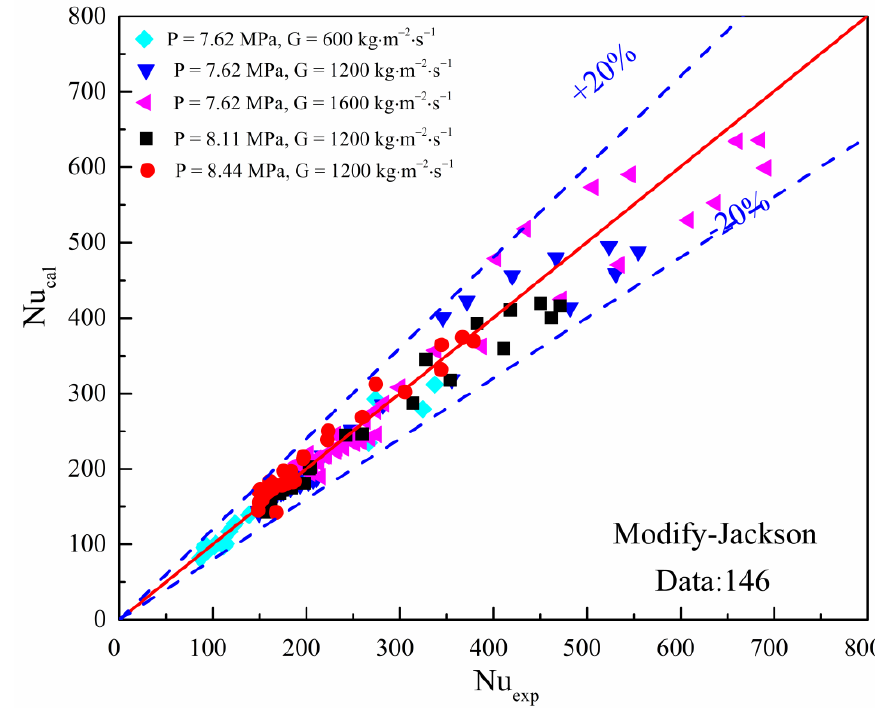
Figure 11. Prediction performance of Nu using the new modified correlation.